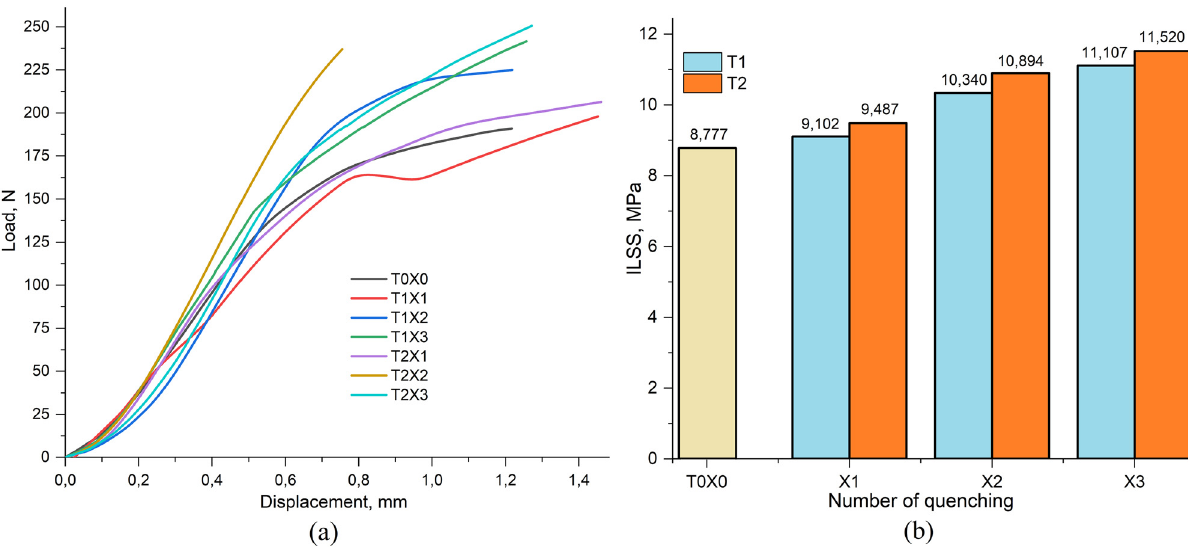
Figure 7: ( a ) Load to displacement curves result from short beam bending test of CFRP composite and ( b ) the ILSS comparison after quenching treatments.